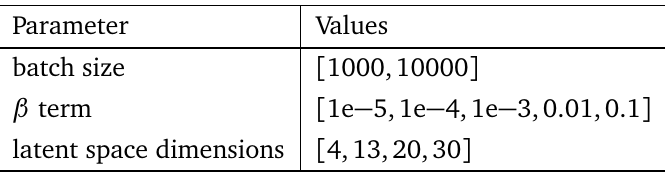
Table 22: ALAD model